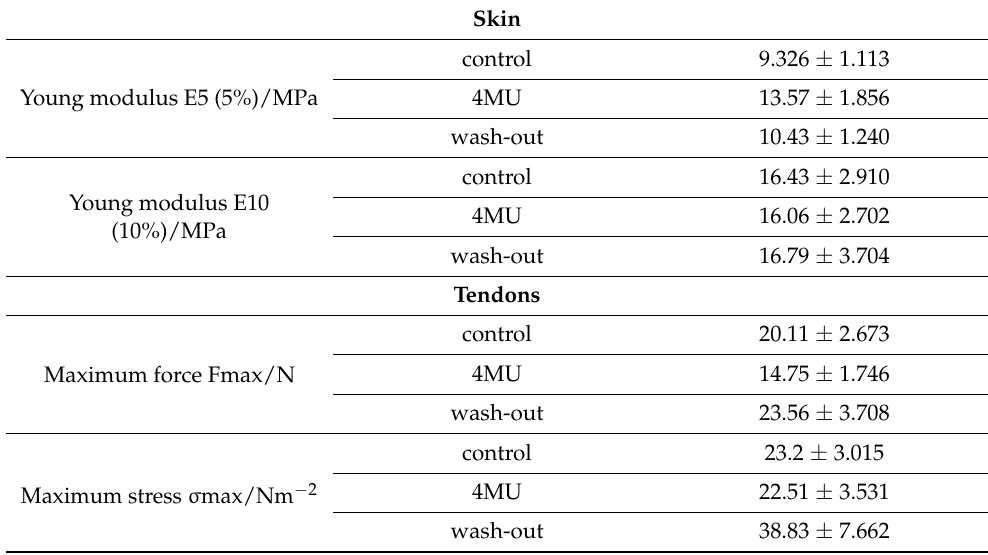
Table 1. The biomechanical properties of skin and tendon in control, 4MU and wash-out groups.